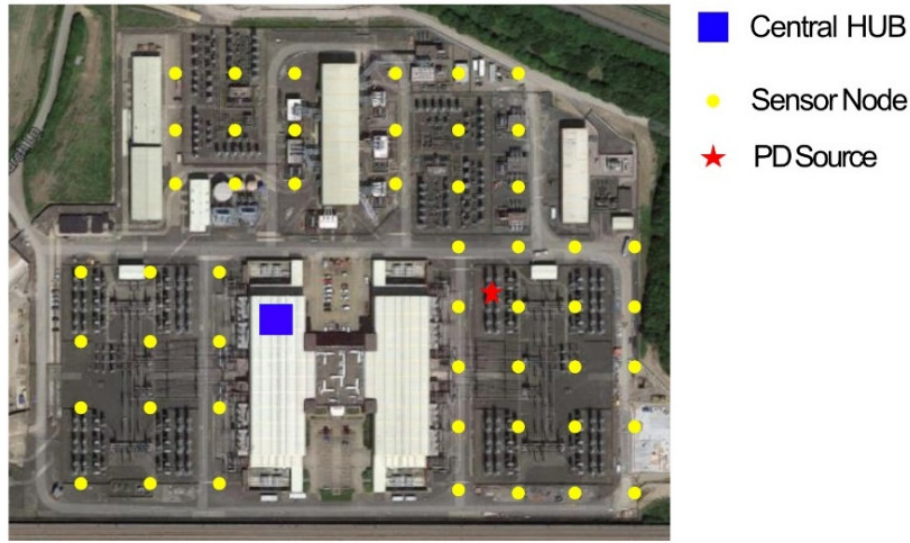
Figure 10. An example of a wireless sensor network (WSN) layout in a switchyard to detect PD using the prototype proposed in [74].